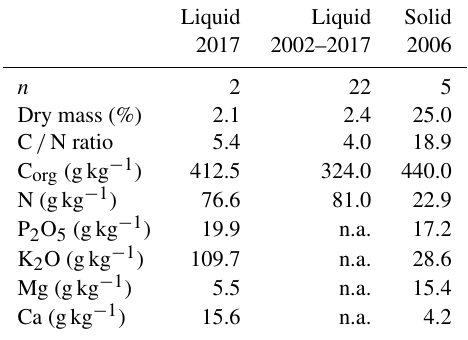
Table E1. Average nutrient concentrations (per dry matter) of liquid and solid manure. The liquid manure data of 2017 are based on samples from 31 March 2017 and include all variables, while for the average over all liquid manure samples between 2002 and 2017 only dry mass, C and N data are available. The solid manure data are based on five samples on 24 January 2006. The number of samples included in the average is given as n . (n.a. means that the average of a nutrient concentration is not